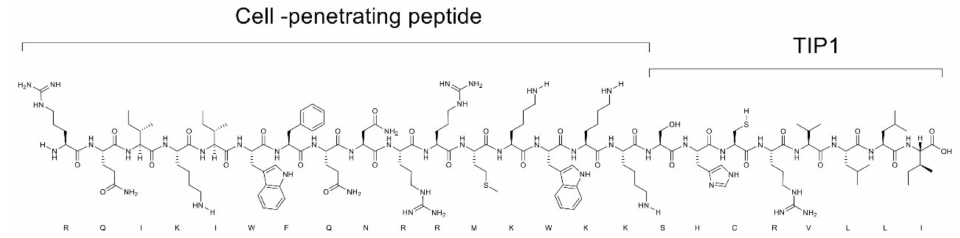
Figure 1. Chemical structure of Toll-like receptor-inhibitory peptide 1. Single-letter amino acid code is shown below the chemical